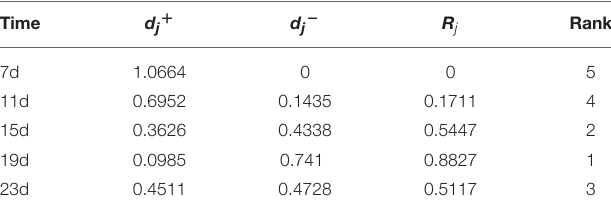
TABLE 3 | Appropriate treatment time evaluated by the TOPSIS